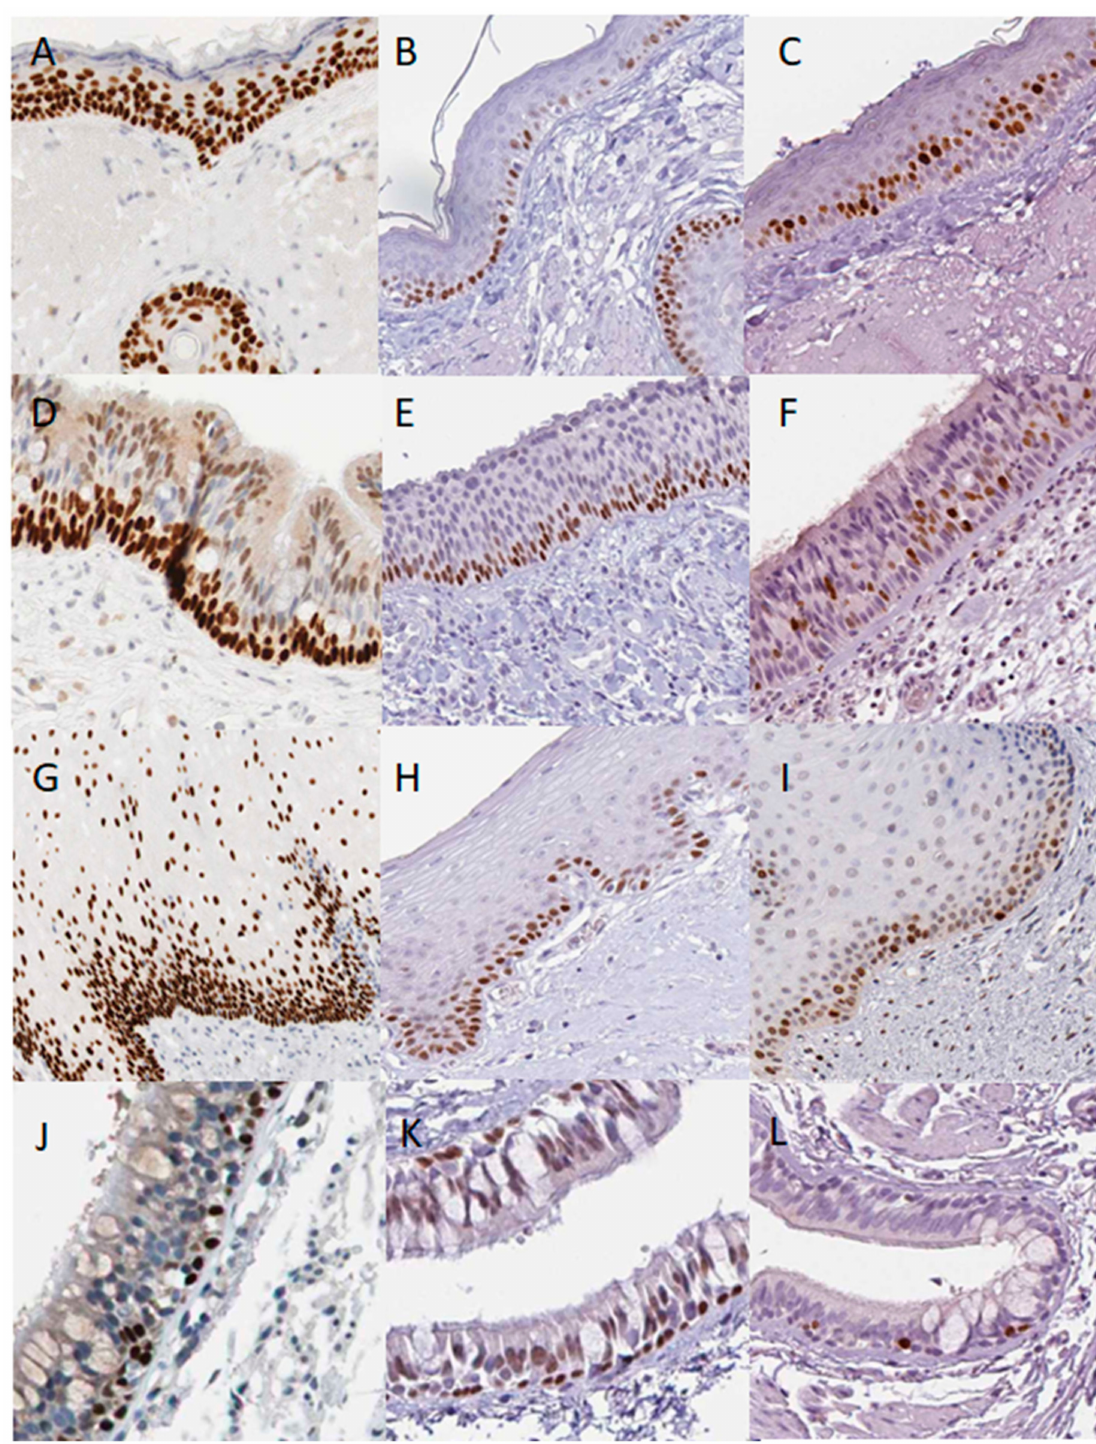
Figure 2. Distribution of p63, p73 and mitotic marker MKI67 in normal human epithelial tissues according to the Protein Atlas database. Skin p63 ( A ), p73 ( B ) and MKI67( C ), Nasopharynx p63 p63 ( D ), p73 ( E ) and MKI67 ( F ) staining; oral mucosa p63 ( G ), p73 ( H ) and MKI67 ( I ) staining; lungs bronchial epithelium p63 ( J ), p73 ( K ) and MKI67 ( L ) staining. In normal human epithelial tissues, the p73 antibody stains basal cells, whereas p63 antibody stains basal as well as early differentiating cells. Proliferating MKI67 positive cells are detected in the basal and suprabasal layers of the tissues, except the non-proliferative